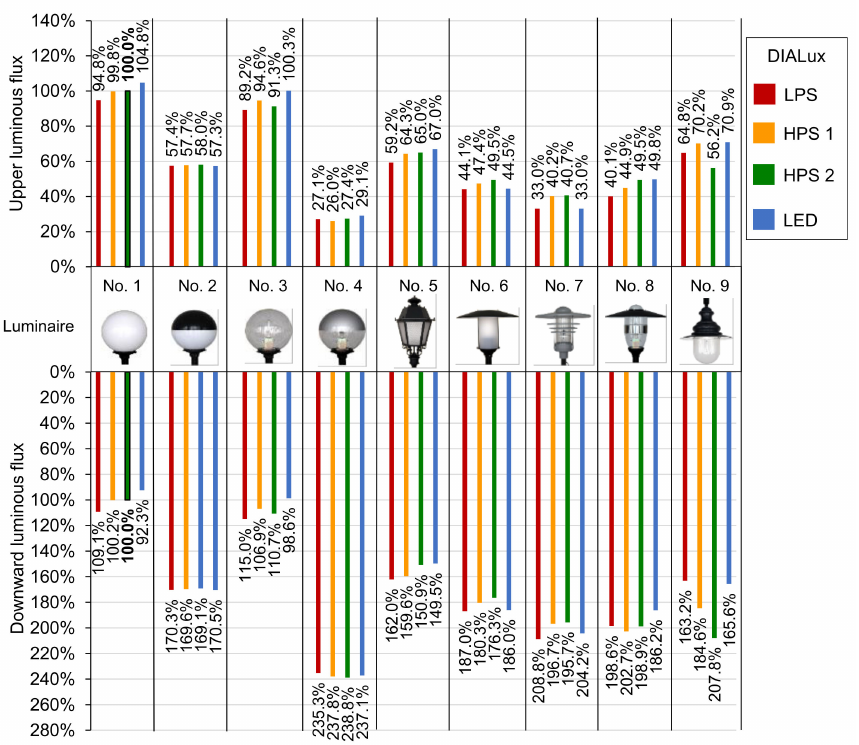
Figure 14. Calculated relative values of luminous flux emitted in the lower and upper half-space by luminaires with identical luminous flux values cooperating with different light sources.